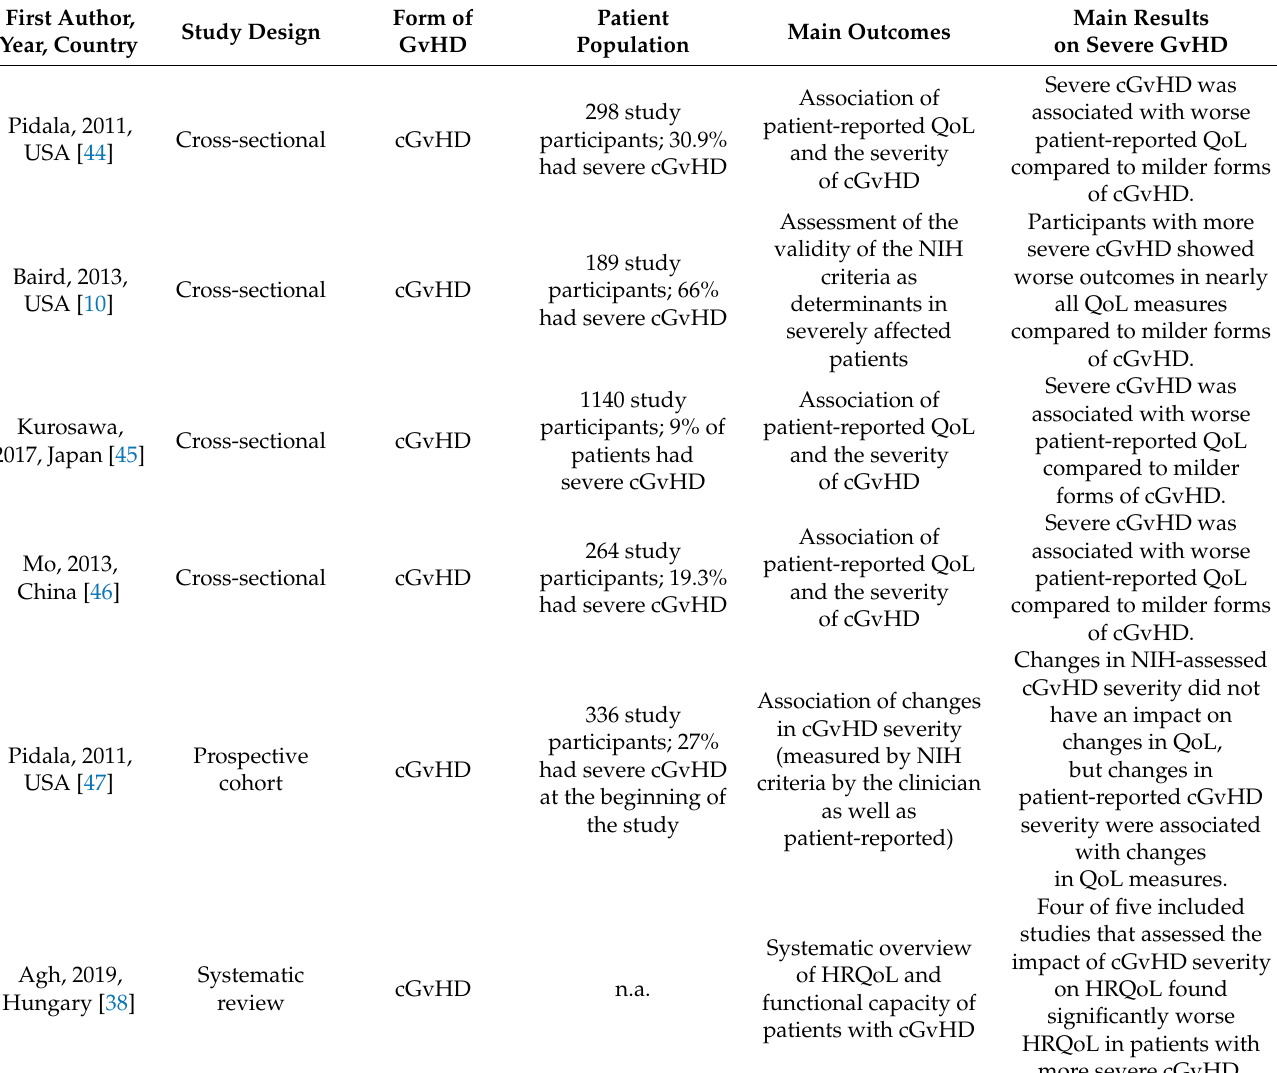
Table 2. Publications identified by the PubMed search on quality of life in patients with GvHD with specific results on severe